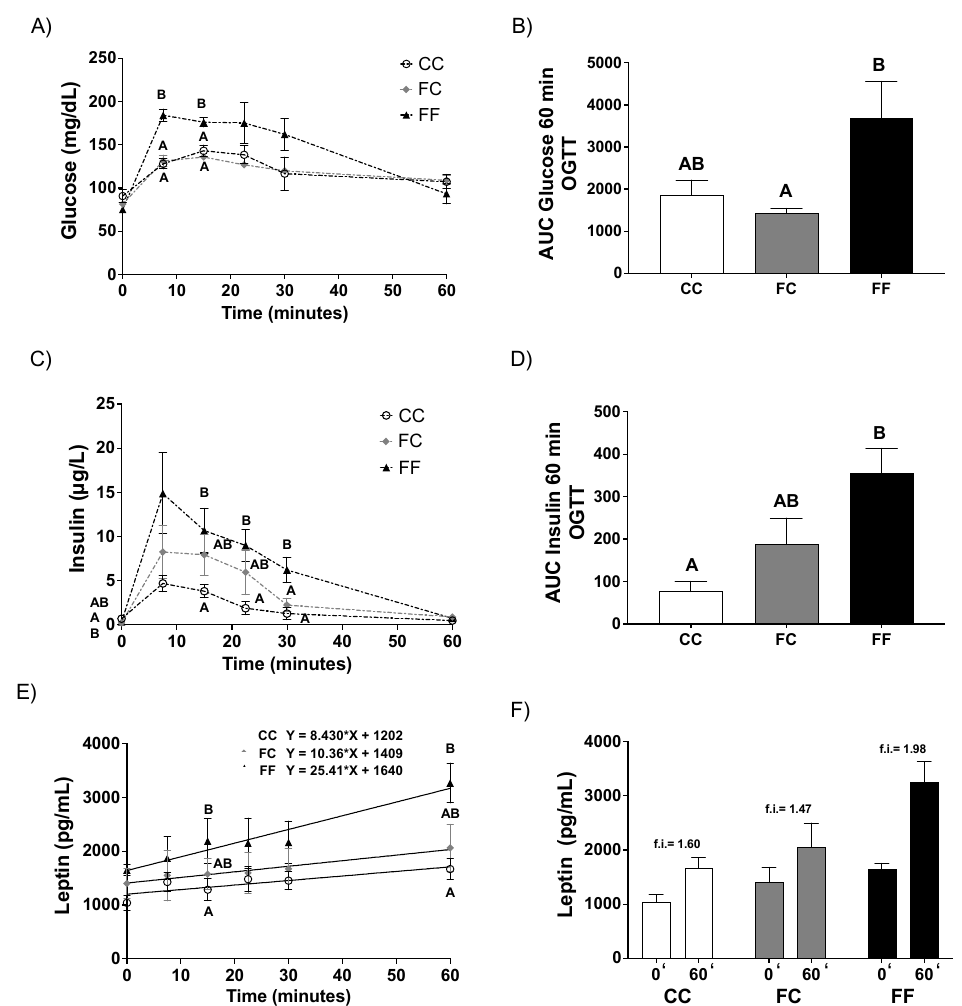
Figure 1. Ingestion of a 10% wt/vol fructose solution throughout gestation in pregnant rats from fructose-fed mothers deteriorates insulin and leptin responses of late pregnant rats. On the morning of the 20th day of pregnancy, animals were subjected to an OGTT in fasted conditions (12 h fasting). After a basal blood sample from the tail vein was drawn, a bolus of glucose (2 g/kg body weight) was administered orally to the rats. Subsequently, blood samples were collected at 7.5, 15, 20, 30, 45, and 60 min after glucose administration, and after the plasma analysis of glucose and insulin was performed, the area under the curve (AUC) for both parameters was calculated. ( A ) Plasma glucose during the OGGT of 20-day-pregnant rats from control mothers (CC, open circles), or pregnant rats from fructose-fed mothers subjected (FF, triangles) or not (FC, grey circles) to fructose intake throughout pregnancy. ( B ) AUC for glucose of CC (empty bar), FC (grey bar) and FF (black bar) 20-day-pregnant rats during the OGGT. ( C ) Plasma insulin during the OGGT of 20-day-pregnant rats from control mothers (CC, open circles), or pregnant rats from fructose-fed mothers subjected (FF, triangles) or not (FC, grey circles) to fructose intake throughout pregnancy. ( D ) AUC for insulin of CC (empty bar), FC (grey bar), and FF (black bar) 20-d pregnant rats during the OGGT. ( E ) Plasma leptin values at different times after the oral administration of a bolus of glucose solution (2 g/kg body weight) to 20-day-pregnant rats from control mothers (CC, open circles), pregnant rats from fructose-fed mothers subjected (FF, triangles) or not (FC, grey circles) to fructose intake throughout pregnancy. Solid lines and equations correspond to linear regressions made with the corresponding values of each experimental group. ( F ) Plasma leptin levels before (t0 ′ ) and 60 min (t60 ′ ) after receiving a bolus of glucose from CC (empty bar), FC (grey bar), and FF (black bar) pregnant rats. Data are mean ± S.E. from 5 animals per group. Values not sharing a common letter are significantly different ( p < 0.05) between the three groups.